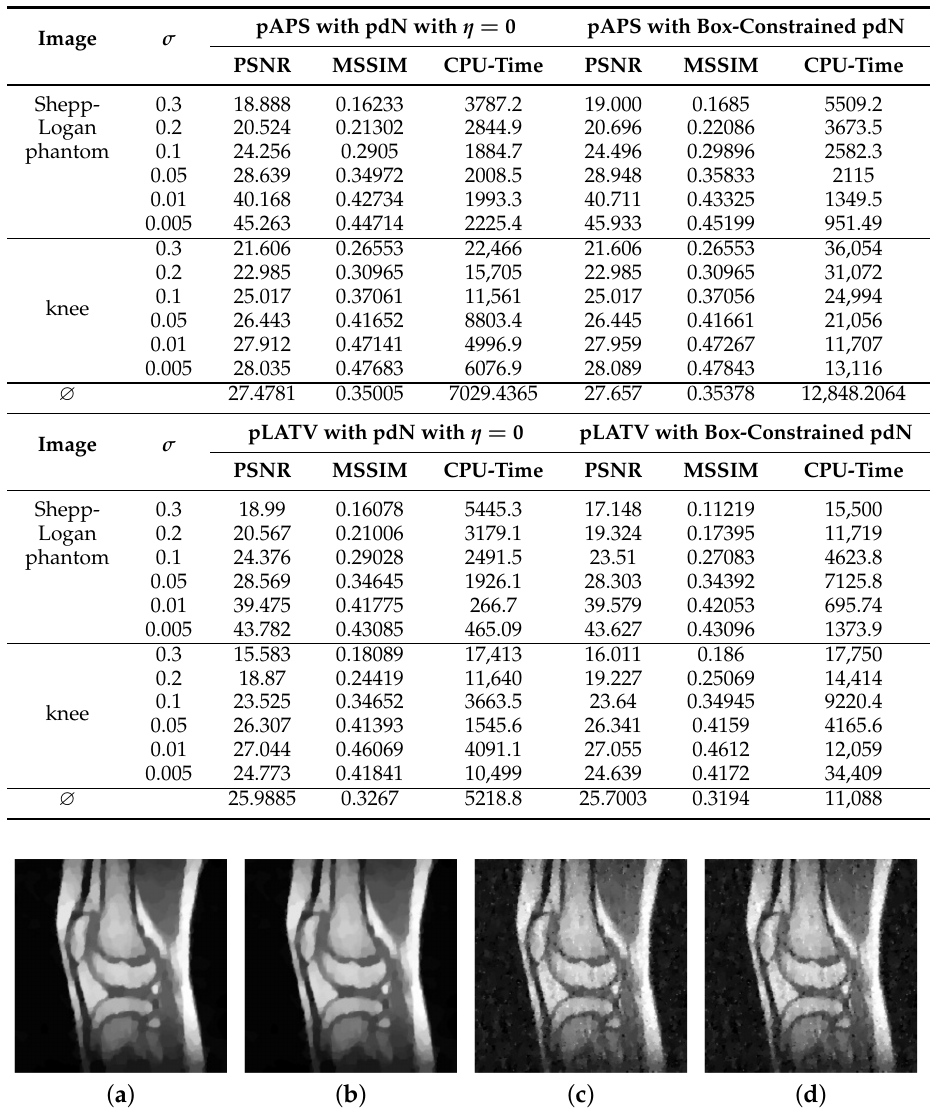
Figure 13. Reconstruction from sampled Fourier data. ( a ) pAPS with pdN with η = 0 (PSNR: